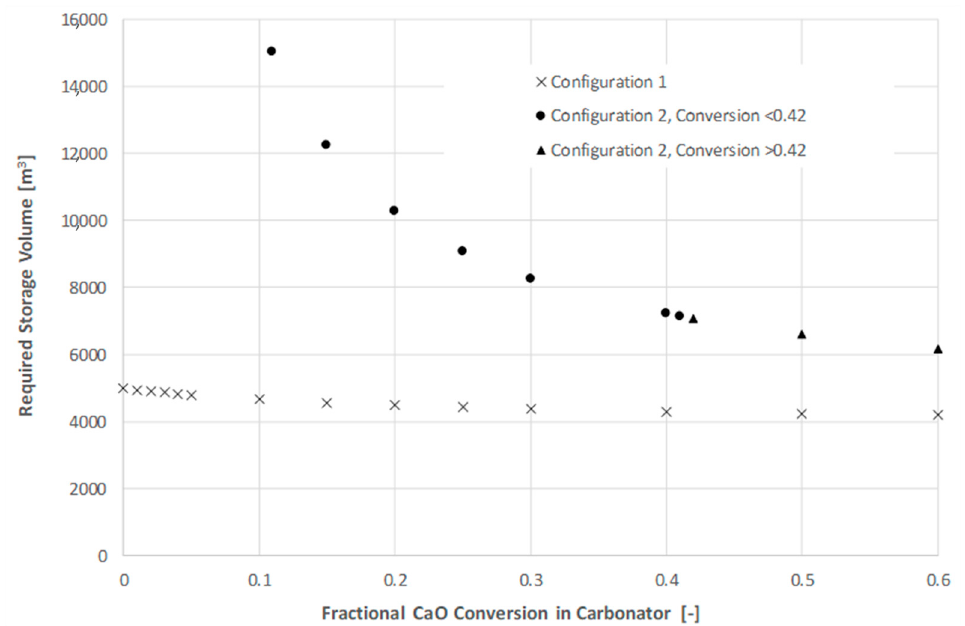
Figure 6. Required CaO/CaCO 3 storage volume as a function of fractional CaO conversion in the carbonator, Con fi guration 1 vs. Con fi guration 2.